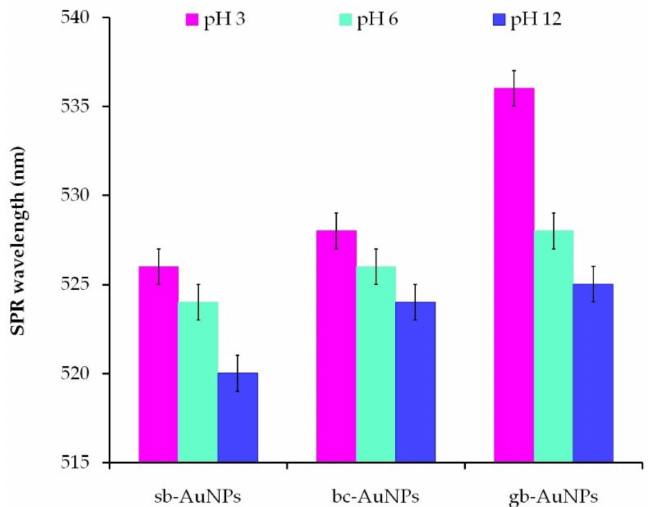
Figure 5. The impact of plant extract pH on the position of the characteristic SPR band of phyto- AuNPs. Synthesis: V extr = 0.75 mL (for sb-AuNPs) and V extr = 1.0 mL (for bc-AuNPs and